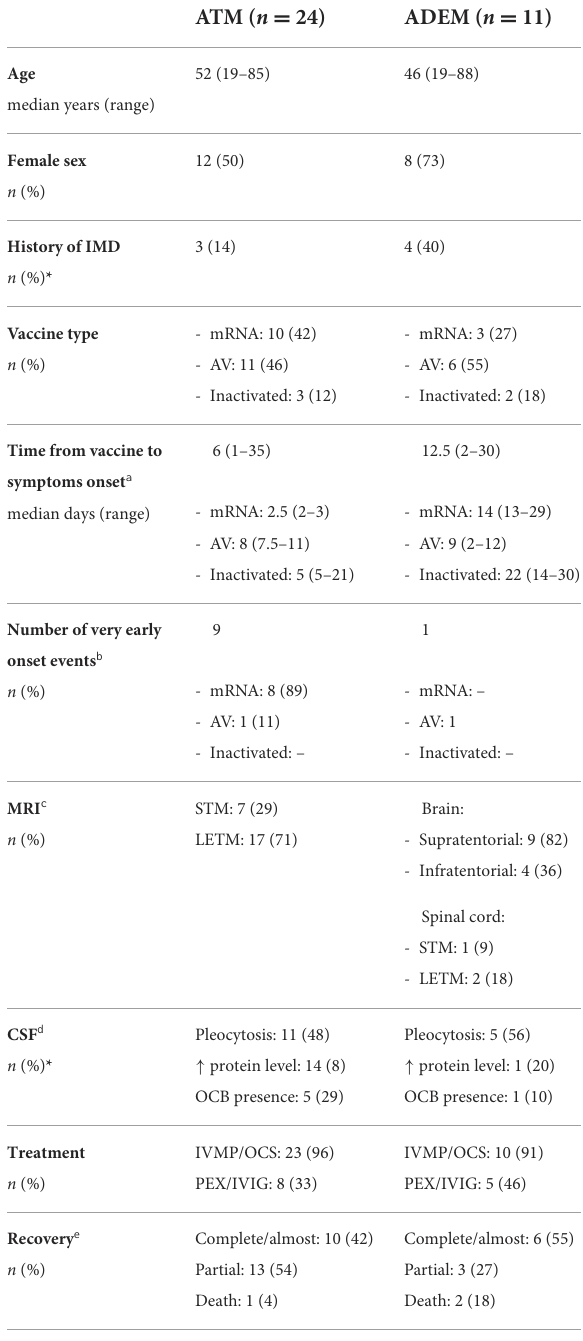
TABLE 1 Characteristics of ATM and ADEM after COVID-19